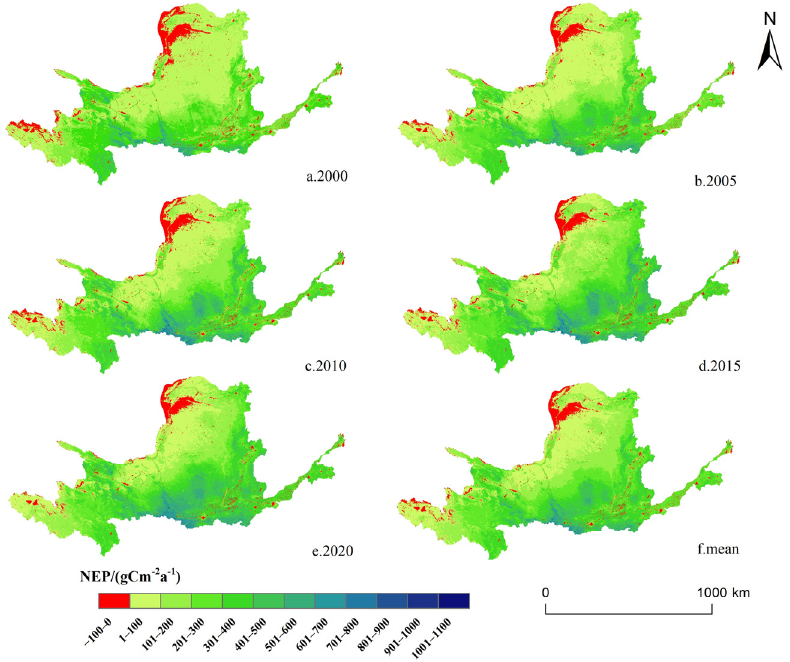
Figure 3. Spatial distribution and annual average NEP values (( a – e ) respectively represent the spatial distribution of NEP values in 2000/2005/2010/2015/2020. The NEP values are classified by 100 intervals, and ( f ) is the mean value).